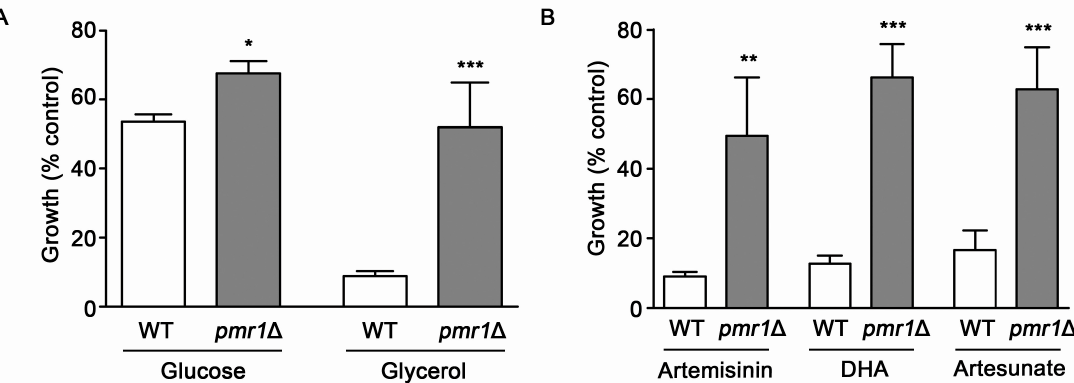
Figure 2. Yeast cells lacking Pmr1p are less susceptible to artemisinin and its derivatives. ( A ) WT and pmr1 ∆ cells were cultured in synthetic complete media supplemented with either 2% glucose (SC) or 2% glycerol (SCG) as a carbon source with vehicle or 10 µ M artemisinin and growth was monitored at 24 h after treatment. ( B ) WT and pmr1 ∆ cells were cultured in SCG medium as described in ( A ) and treated with vehicle, 10 µ M artemisinin, 2 µ M dihydroartimisinine (DHA), or 10 µ M artesunate for 24 h. Percent growth compared to untreated controls for each strain is shown. Results are from three independent experiments; values are the mean + SD with differences between strains analyzed using two-tailed unpaired Student’s t -test; *** P < 0.001.